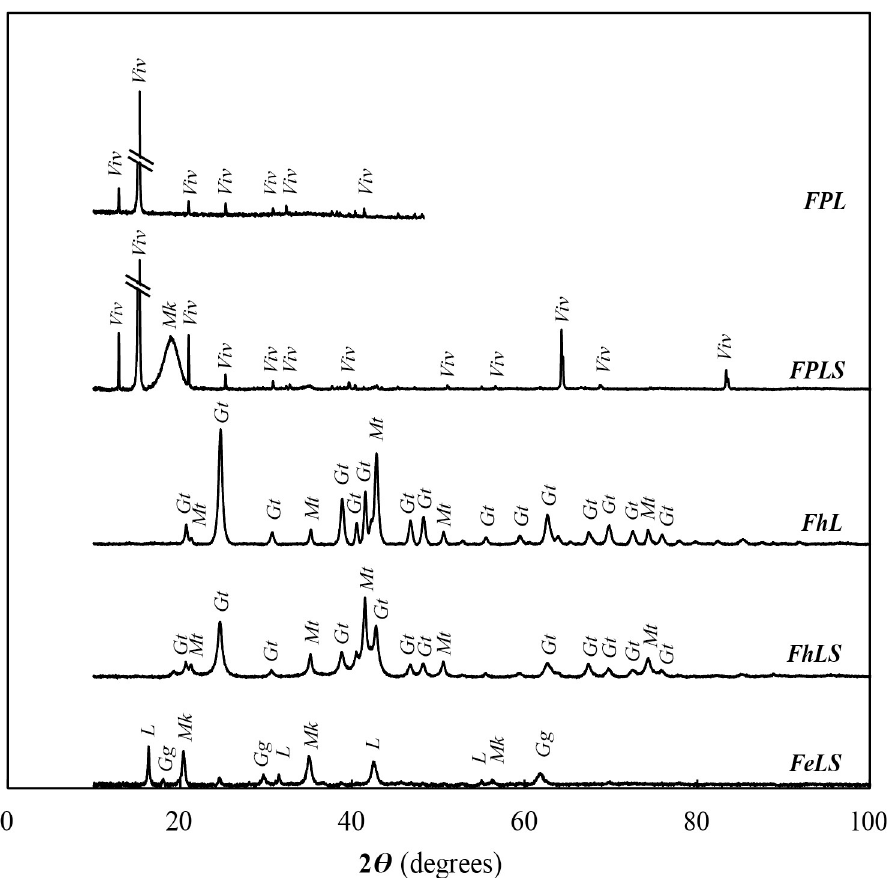
Fig 6. XRD analysis of mineral products obtained in Lake Pavin enrichment cultures with different added iron phases. Anoxic lake water was incubated with Fe 2+ , ferrihydrite or amorphous Fe(III)-phosphate, with or without sulfate, and lactate. Viv: vivianite, Mk: mackinawite, Gg: greigite, Gt: goethite, Mt: magnetite, L: lepidocrocite. Hatches indicate where high-intensity peaks have been truncated. Mineralogical analyses were performed after significant evolution of the original added iron phase was visually observed: FeLS = 18 d, FPL & FPLS = 50 d, FhL & FhLS = 75 d.